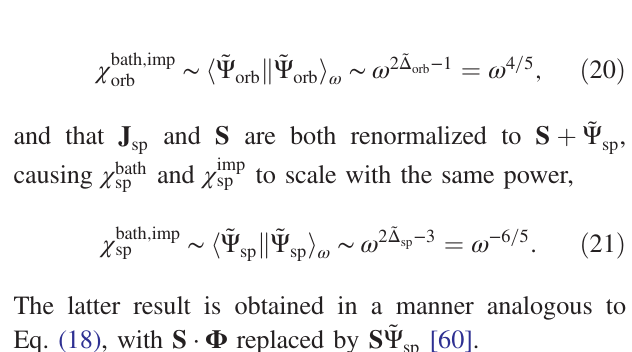
; T ; T shrinks, while that of the SS regime ½ T remains constant. (e) – (h) We find the same ss orb (cid:2) sp ss (cid:2)